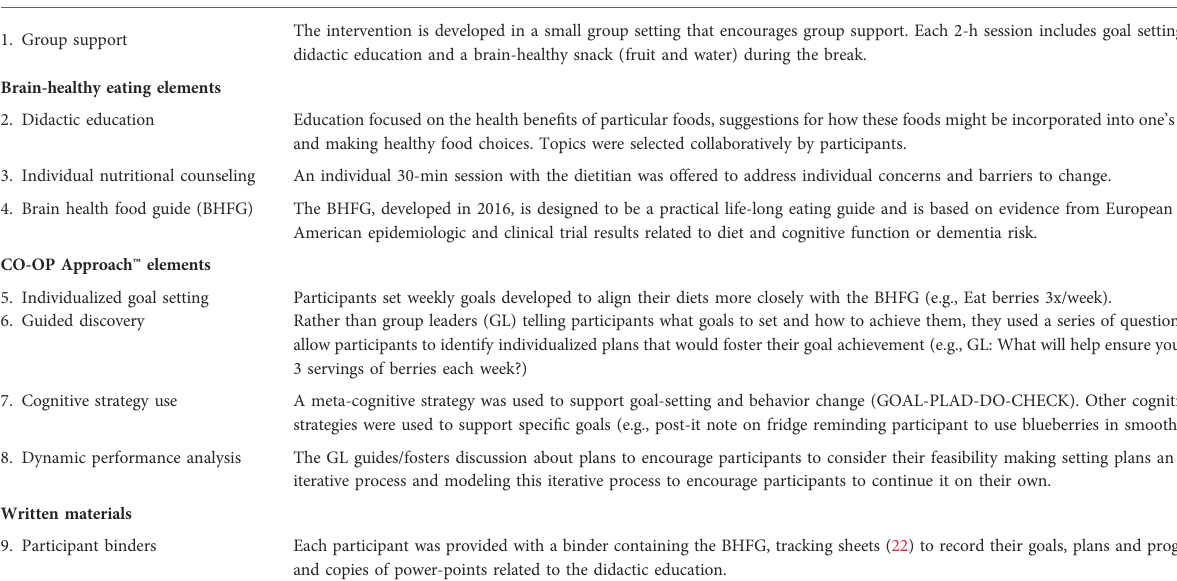
TABLE 1 Components of the Baycrest Brain-Health Eating